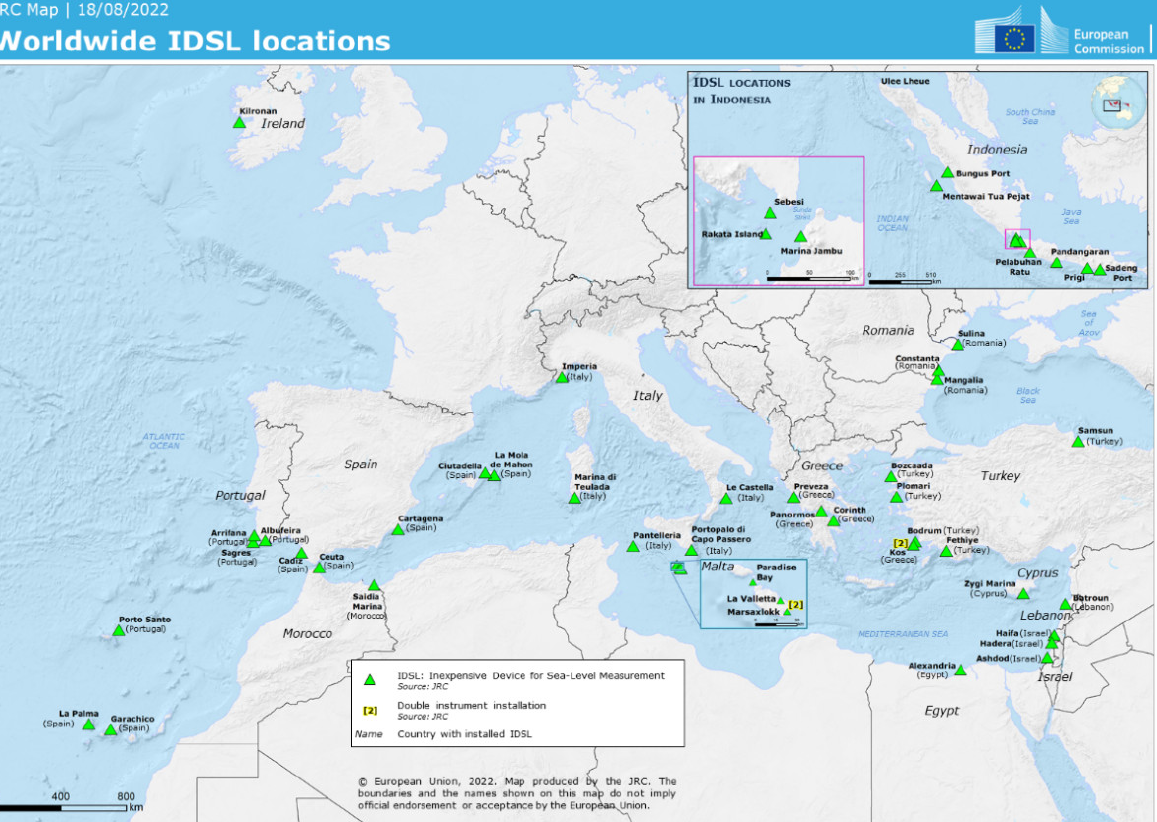
Figure 4. Installed IDSL devices in the North Atlantic Ocean, Mediterranean Sea, Black Sea and Indonesia.